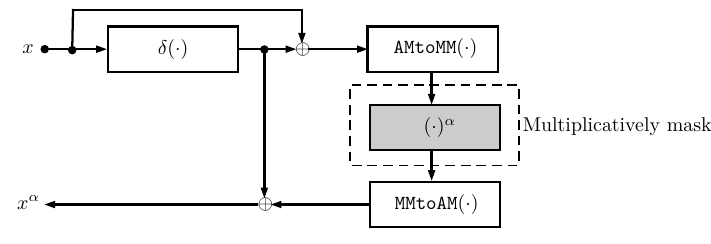
Figure 2: GPQ power function processing : x 7→ x α